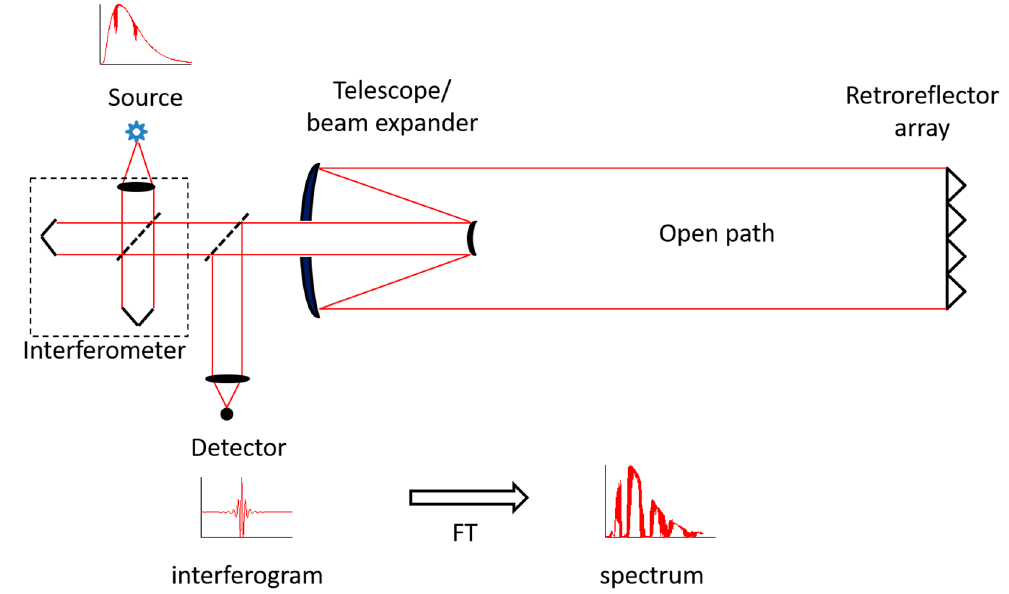
Figure 2. Schematic optic diagram of the open path FTIR system.